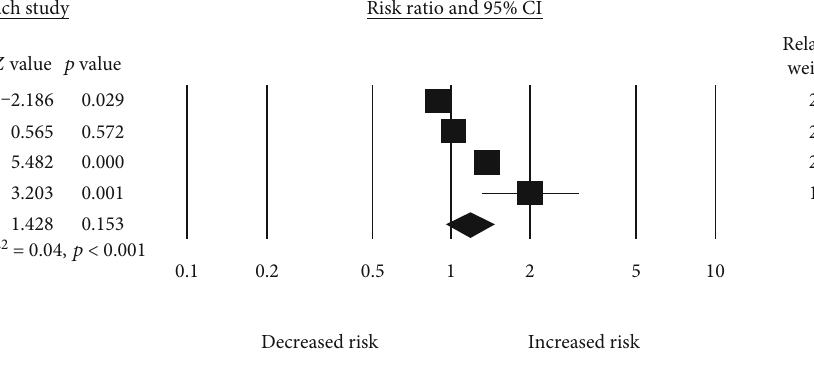
Figure 2: Association between anemia and risk of PD.